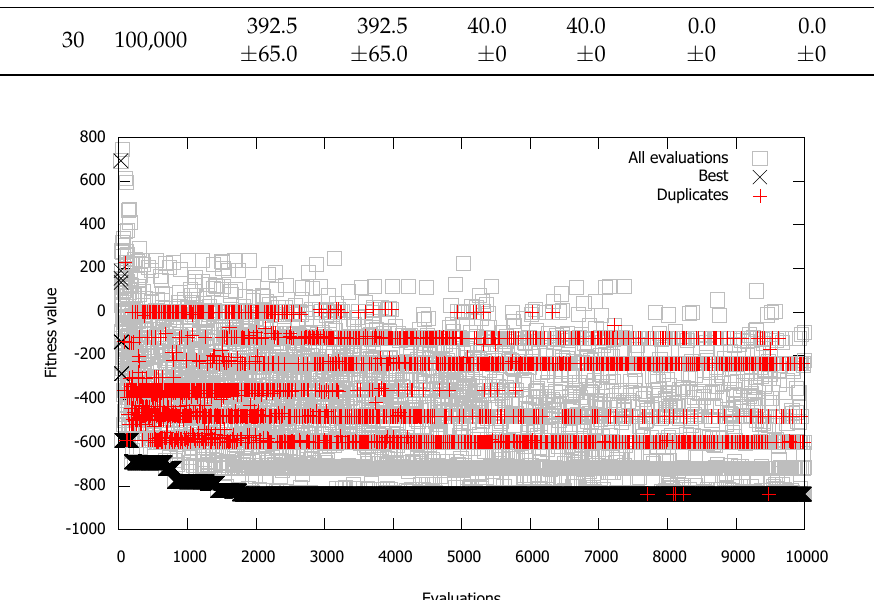
Figure 8. One run of the ABC algorithm on the Schwefel 2.26 problem for n = 2 and Pr =